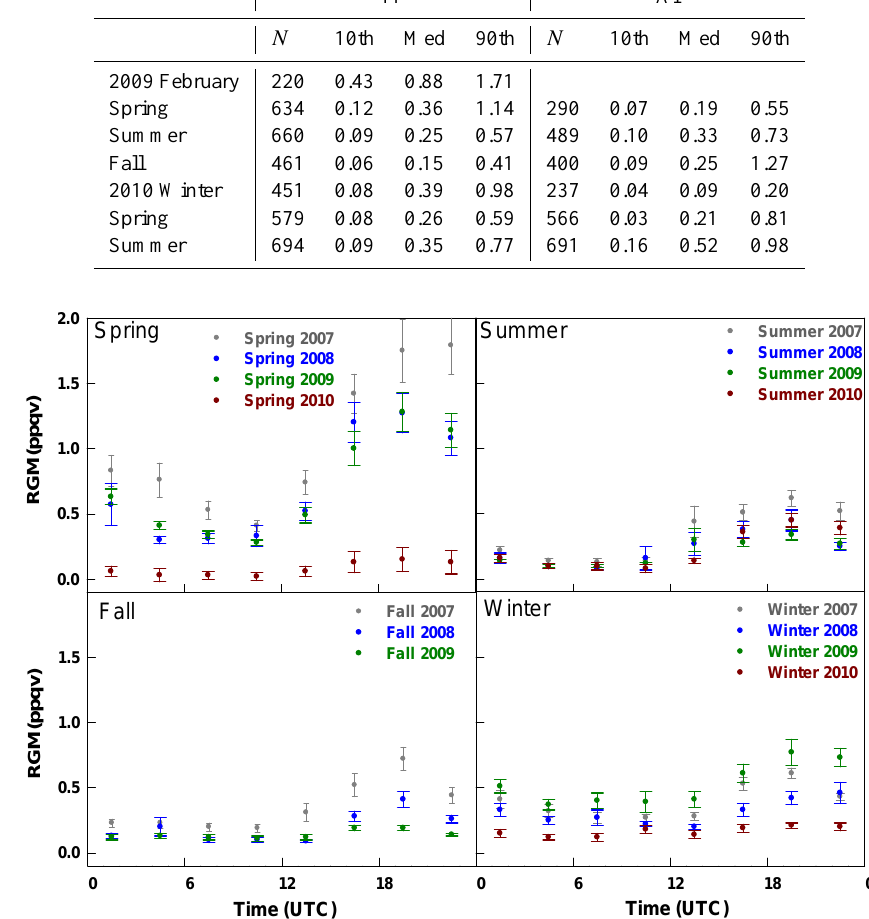
Figure 8: Seasonally averaged diurnal cycles of RGM with standard deviation of means at TF. Fig. 8. Seasonally averaged diurnal cycles of RGM with standard deviation of means at